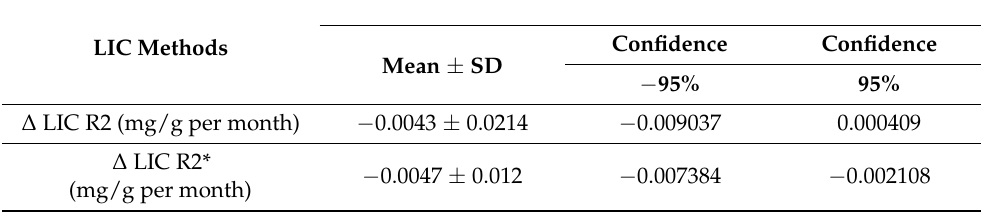
Table 3. Mean rate of change of liver iron concentration (LIC).